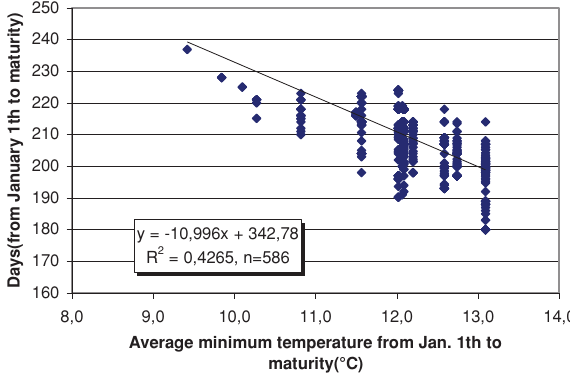
Figure 8. Relationship between maturity time and minimum temperature from 1th of January to maturity date, (Újfehértó,